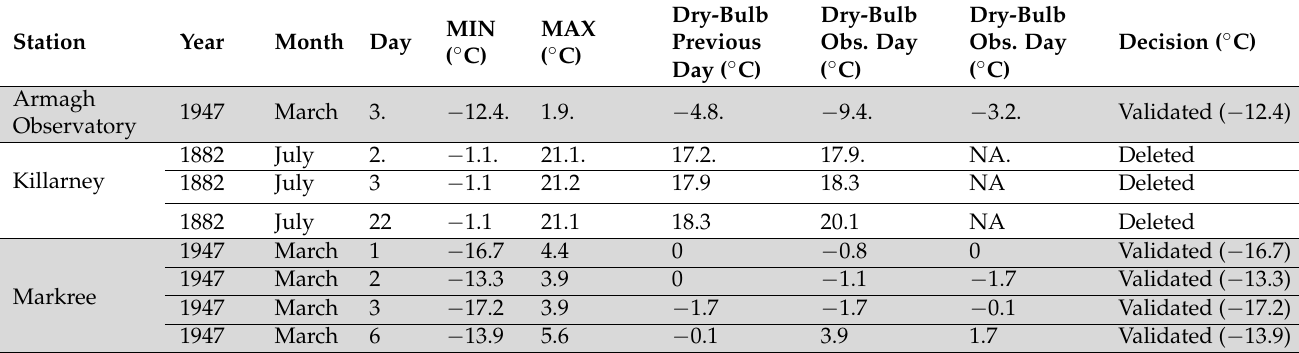
Table A1. Flagged lower daily MIN threshold exceedance (flag 1) and the dry-bulb thermometer registered on previous and observation days.